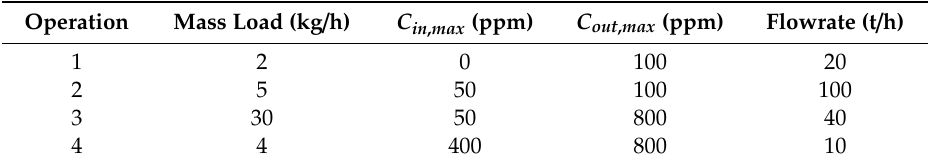
Table 1. Data limits of the example